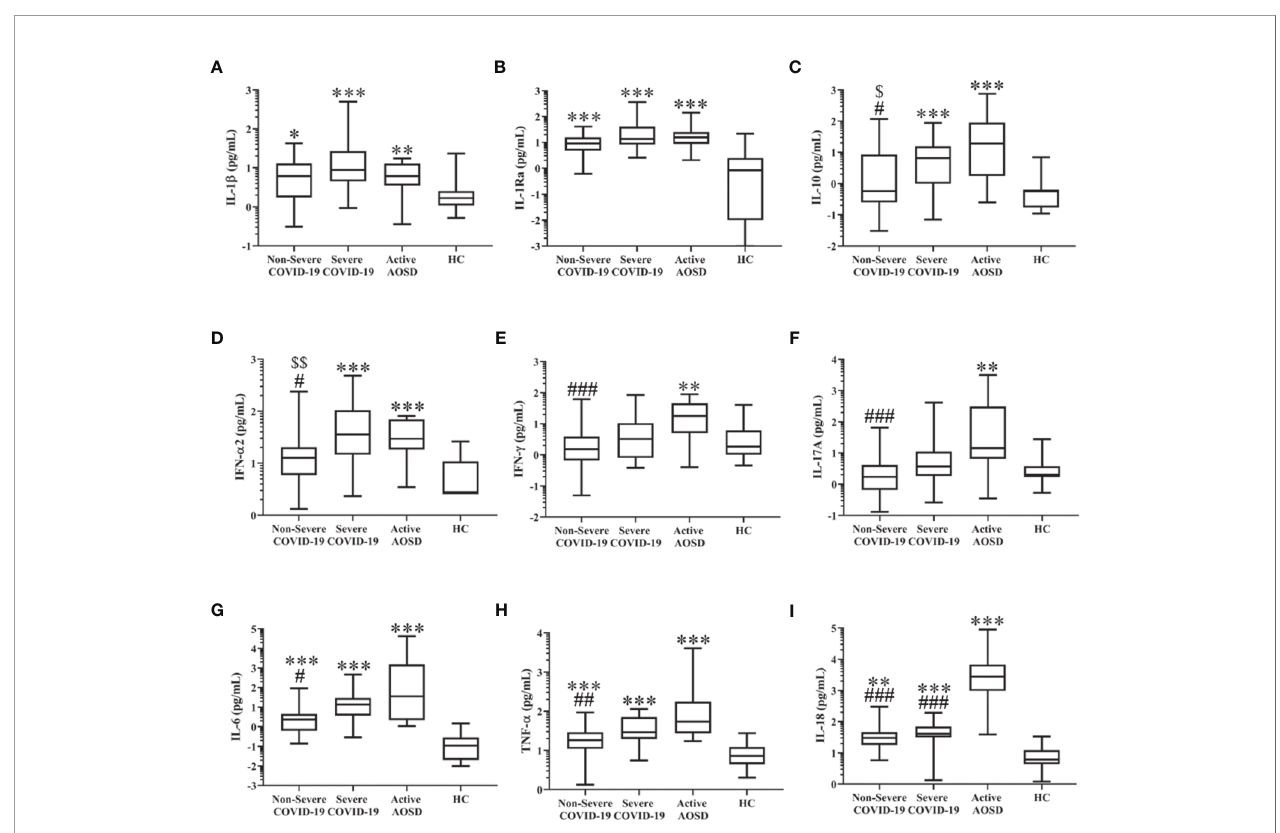
FIGURE 2 | Comparison of plasma levels of cytokine pro fi les in COVID-19, AOSD and HC. The difference in levels of IL-1 b (A) , IL-1Ra (B) , IL-10 (C) , IFN- a 2 (D) , IFN- g (E) , IL-17A (F) , IL-6 (G) , TNF- a (H) , and IL-18 (I) among non-severe COVID-19, severe COVID-19, active AOSD, and healthy control (HC). COVID-19, coronavirus disease 2019; AOSD, adult-onset Still ’ s disease; IFN, interferon; IL, interleukin; IL-1Ra, interleukin-1 receptor antagonist; TNF- a , tumor necrosis factor- a . Data are presented as a logarithmic scale and box-plot diagrams, with the box encompassing the 25 th percentile (lower bar) to the 75 th percentile (upper bar). The horizontal line within the box indicates median value respectively for each group. *p-value < 0.05, **p-value < 0.01, ***p-value < 0.001, versus HC; # p-value < 0.05, ## p-value < 0.01, ### p-value < 0.001, versus AOSD patients; $ p-value < 0.05, $$ p< 0.01, versus severe COVID-19 patients, determined by the Kruskal-Wallis test with a post-hoc Dunn ’ s